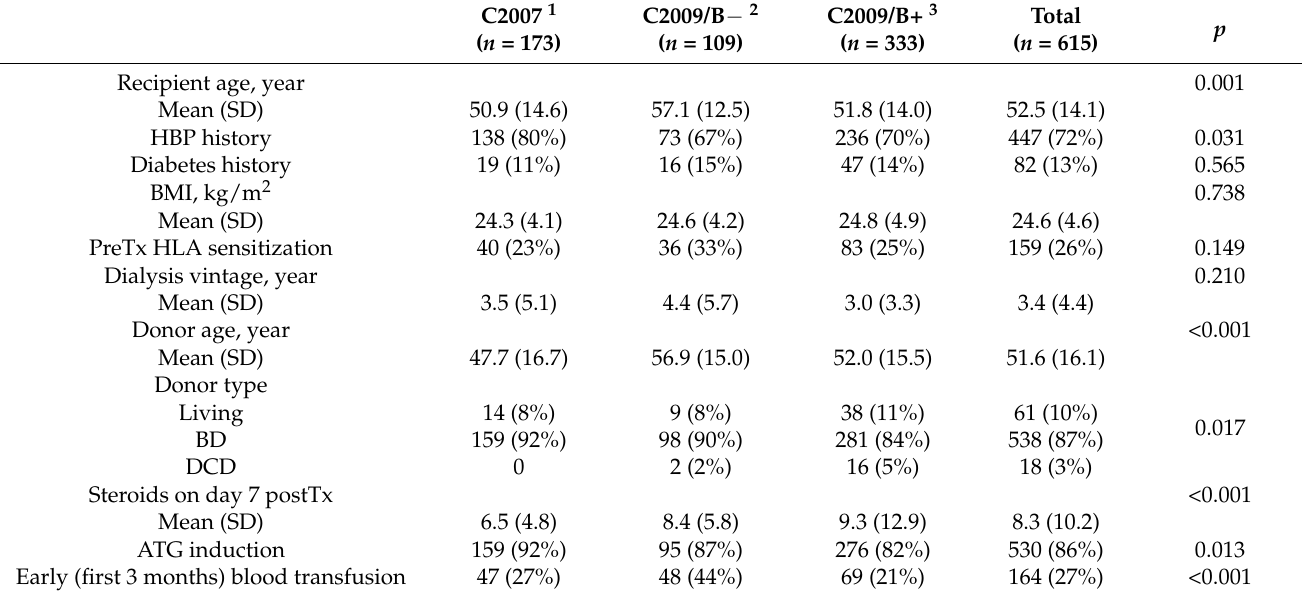
Table 1. Recipients’